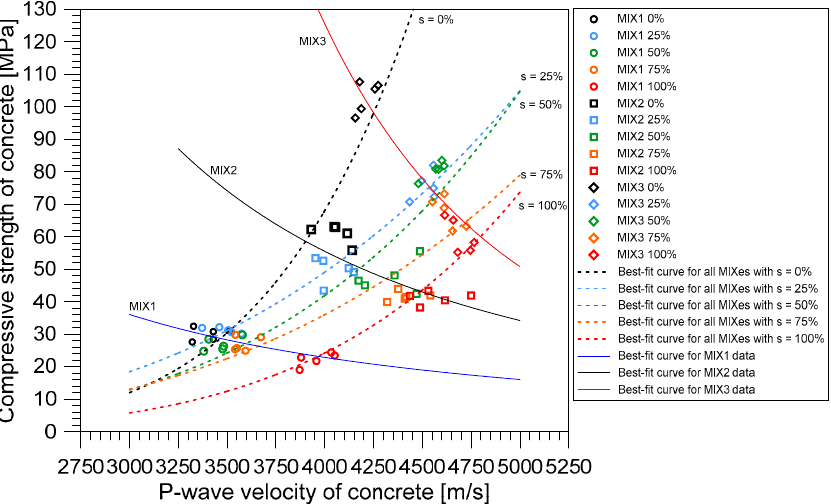
Figure 16. Relationship between P-wave velocity and the compressive strength of saturated concrete.